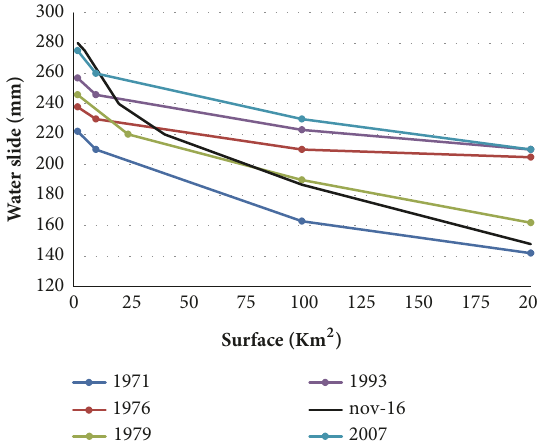
Figure 7: Spatial extension of exceptional episodes exceeding 200 mm in 4